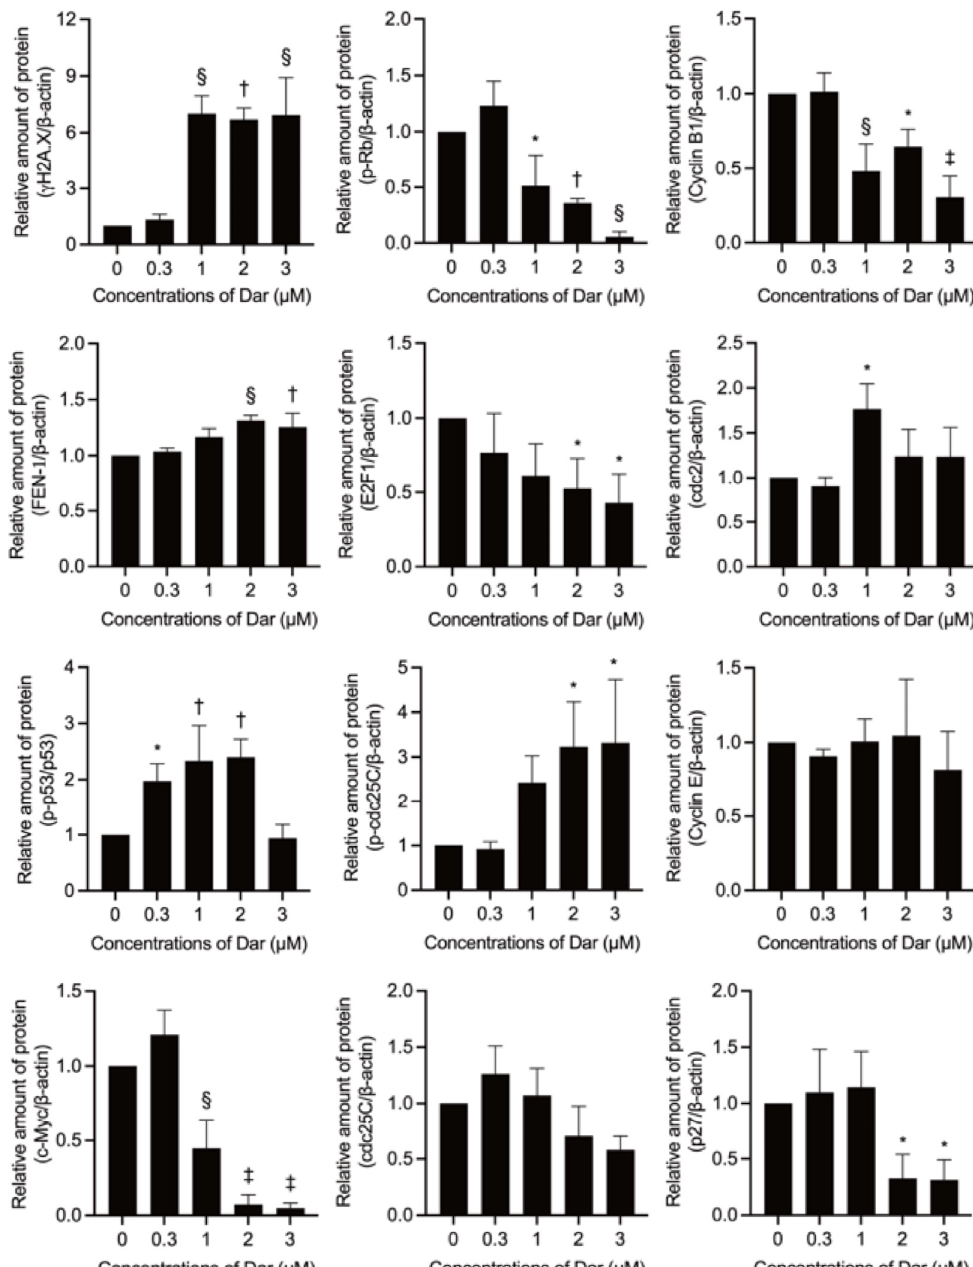
the same experiment samples were used for analysis.